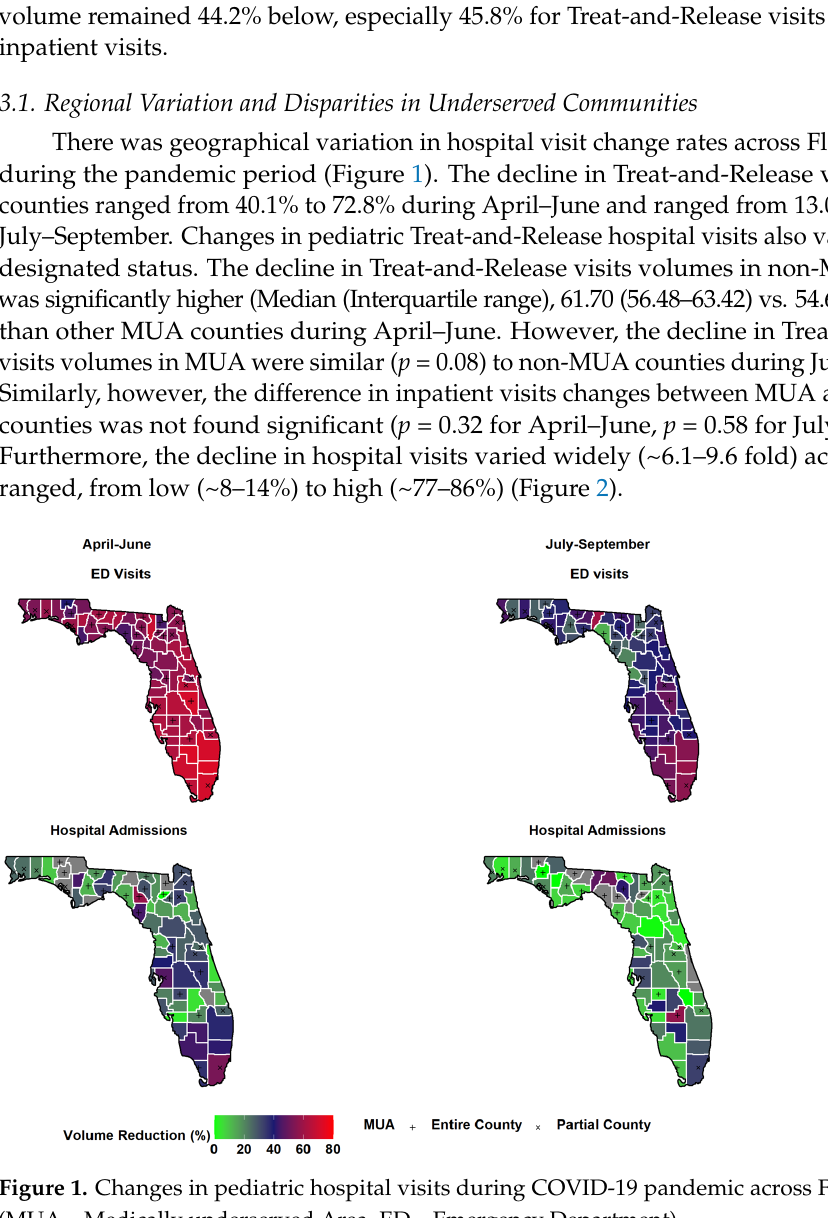
Figure 2. Distribution of pediatric ED visits and hospital claim charge reduction in Florida hospitals. (Dotted line represents Median and Interquartile range).